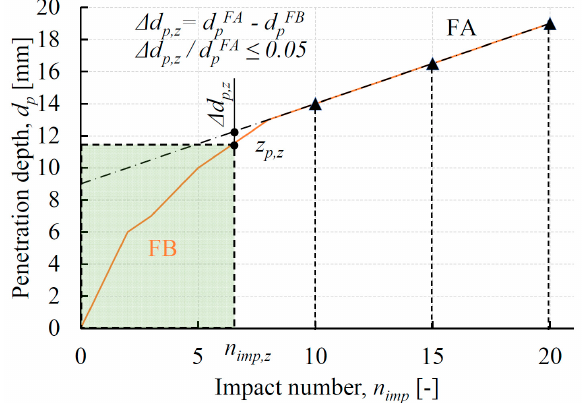
Figure 7. The manner of determining the range of the surface disturbance zone ( z p,z ) based on penetrometer test results. Where: FA—the linear approximation of the test results for n imp = 10, 15 and 20; FB—tests results.